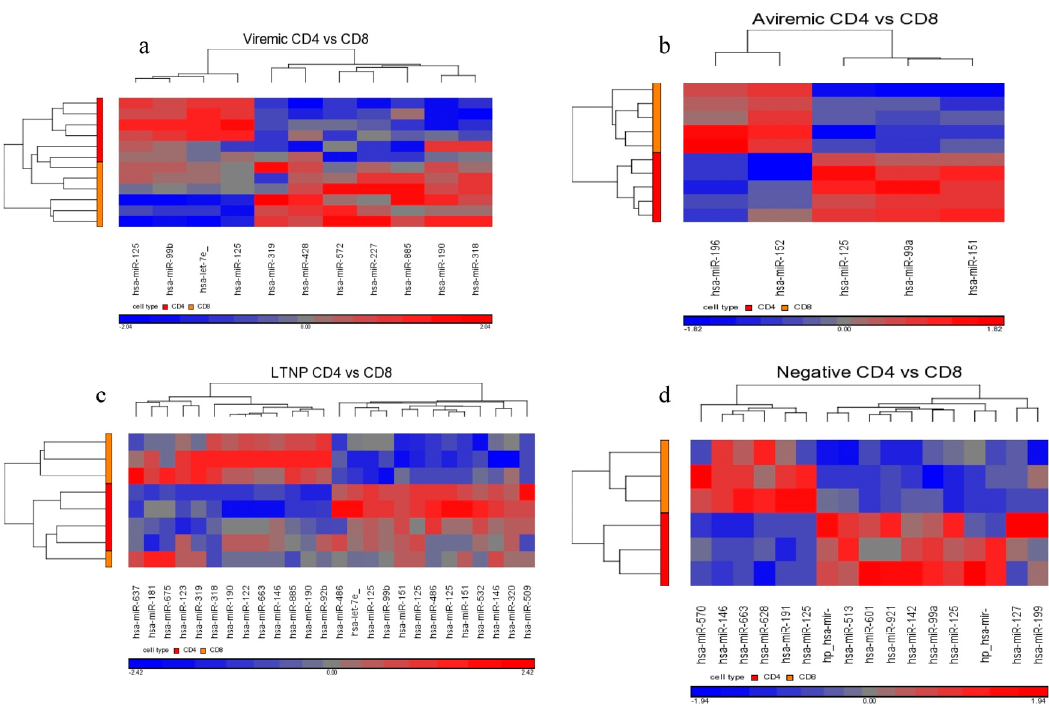
Figure 13. Heat map representation of miRNAs DE between CD4+ and CD8+ T-cells from disease groups viremic ( a ); aviremic ( b ); LTNP ( c ); and negative ( d ). Non-FDR method with p < 0.01 was used. For each cell type, viremic n = 6, aviremic n = 5, LTNP n = 4, and negative n = 3.